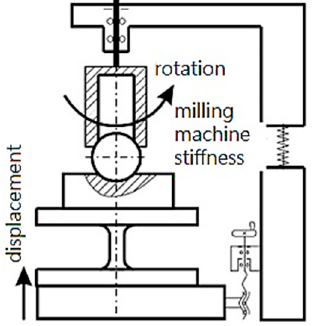
Figure 4. Loading schematics (old).